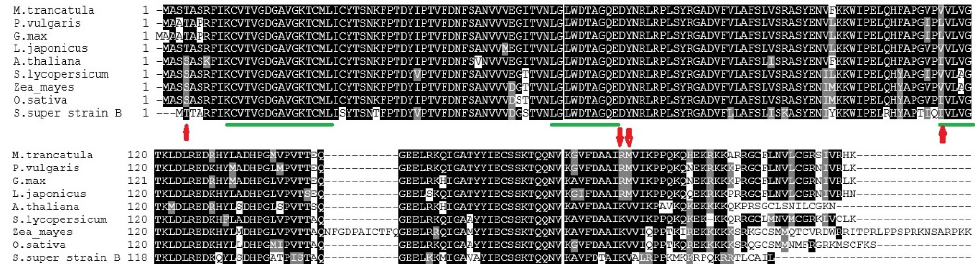
Figure 4. Multiple sequence alignments and the proteins of S. lycopersicum super strain B (ROP10) and those retrieved from the genomic databases: A. thaliana (At1g07410, O. sativa (LOC_Os03g60870), S. lycopersicum (Solyc06g076450), Z. mays (GRMZM2G473906), L. japonicus (chr3.CM0792.300.r2.d), M. truncatula (Medtr4g064897), P. vulgaris (Phvul.011G061100), and G. max (Glyma11g14360). Black boxes represent identical residues while gray ones represent conservative substitutions. Alignments were performed with Clustal Omega in MEGA7 followed with Boxshade. Red arrows designate amino acid substitutions in legumes against non-legumes. The conserved domains of ROP are indicated by green lines.